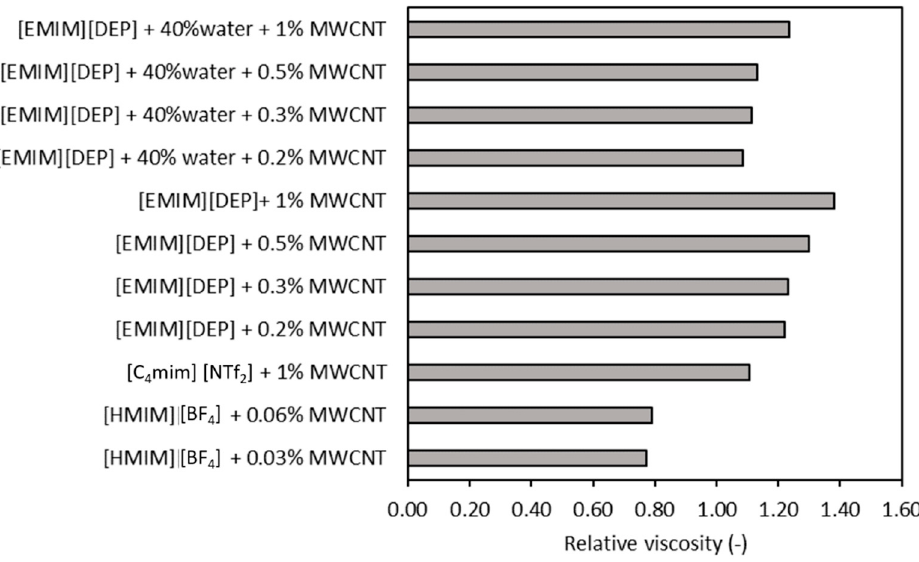
mixtures, but the actual influence of the base fluid seems larger at higher nanoparticles’ mass concentrations. Figure 7. Influence of the base fluid on relative viscosity values of fluids with MWCNTs [34,37,47]. In Figure 8, a comparison for alumina and different base ionic liquid is depicted. A smaller upsurge in viscosity was observed for base fluids from ionic liquids and water